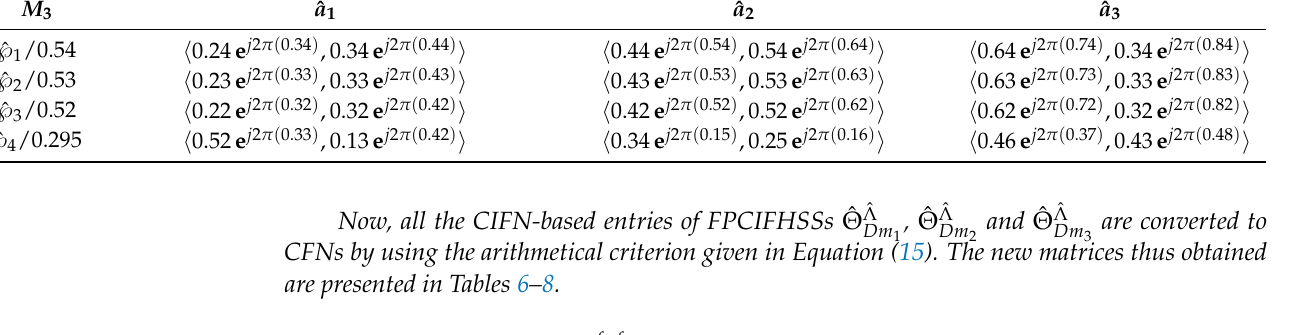
Table 5. Matrix formation of FPCIFHSS ˆ Θ ˆ Λ